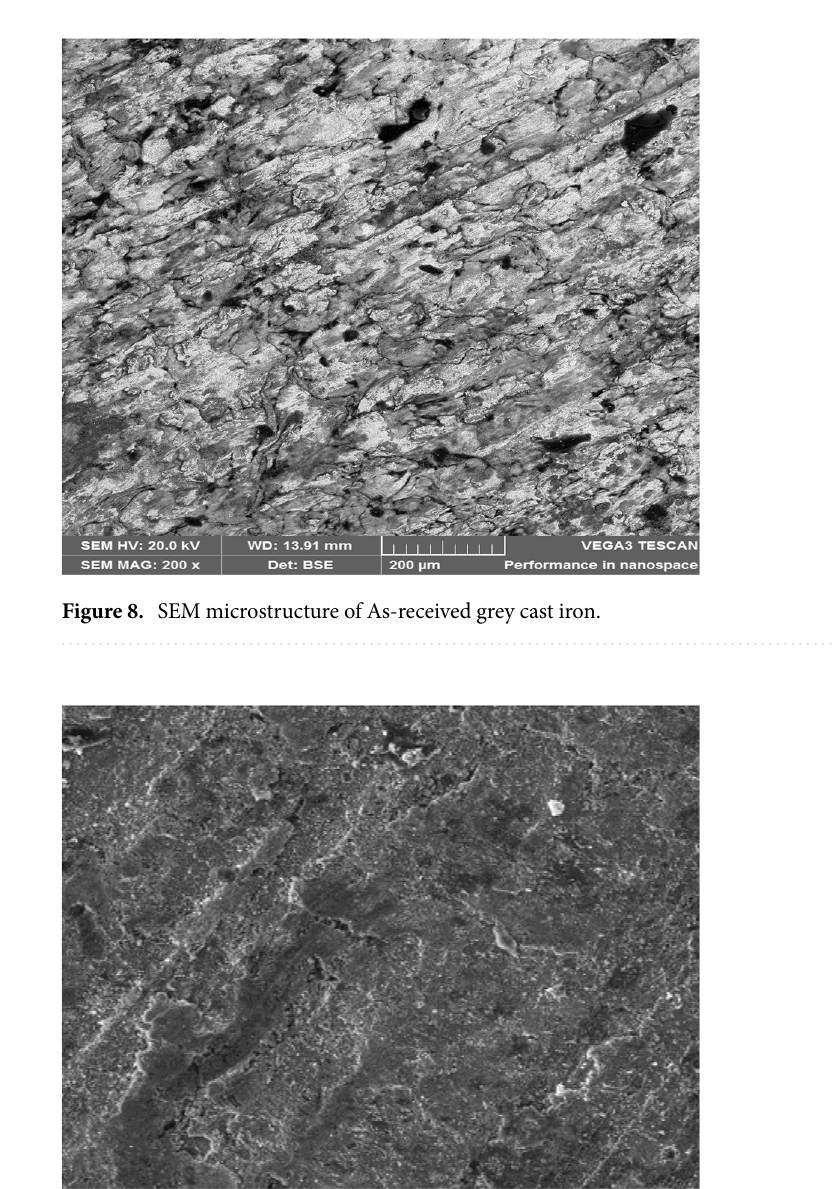
Figure 9. SEM microstructure of grey cast iron carburized at 900 °C for 60